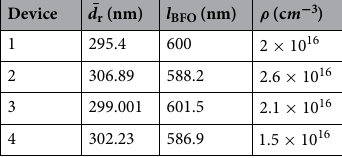
Table 2. The parameters of the four devices used to determine the I – V curves in Fig. 4.